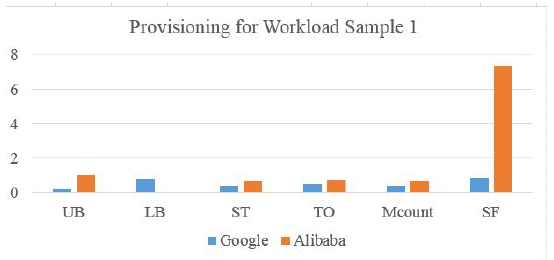
Figure 16. Scaling Ratios for Google and Alibaba Workload Type 1.